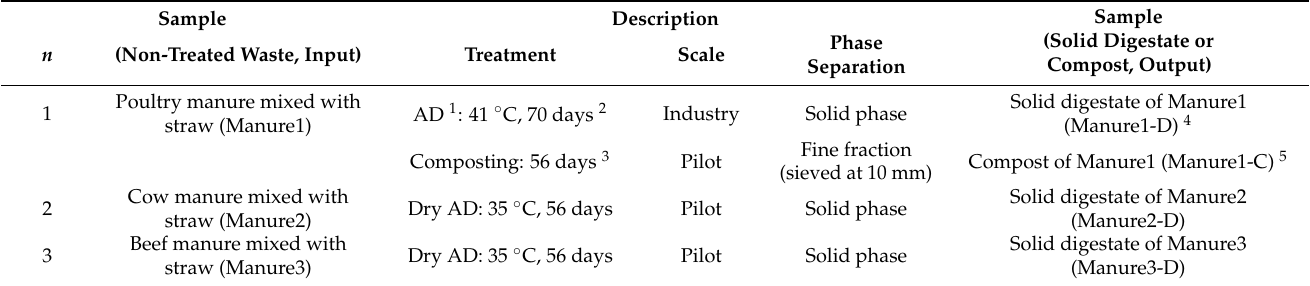
Table 1. Composition of organic wastes and treatment